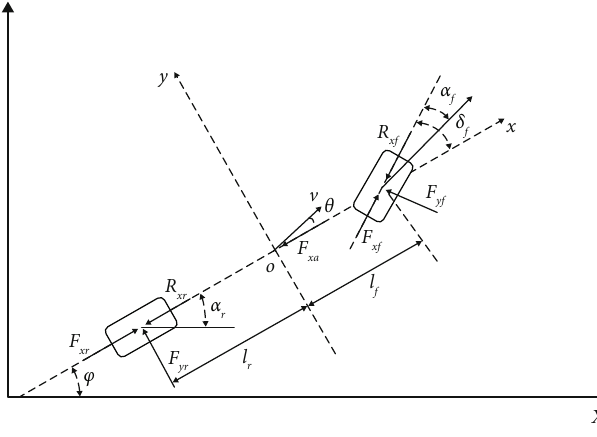
Figure 1: The 3-DOF vehicle